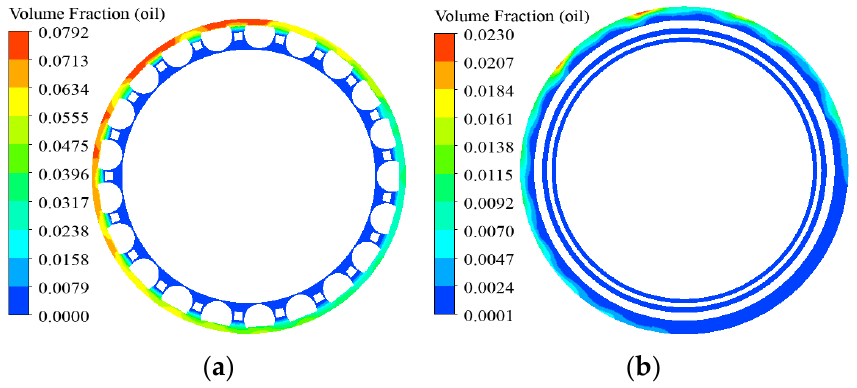
Figure 17. Lubricating oil distributions at the small roller ribs of the bearings. ( a ) Outer ring rib structure; ( b ) Inner ring rib structure.